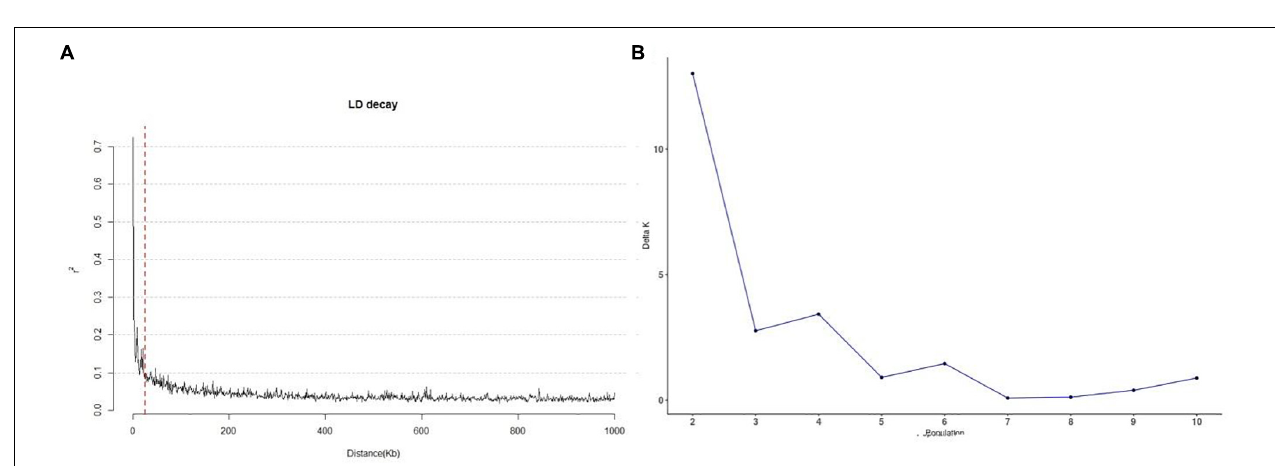
FIGURE 1 | Pearson correlation coefficients for the four yield traits evaluated in the four environments. Four environments: (A) 2015Fy, (B) 2016Tq, (C) 2016Fy, and (D) 2017Tq. Four traits: Plant height (PH), tiller number (TN), stem diameter (SD), and fresh weight per plant (FW). ** Indicates significance level at 0.01. *** Indicates significance level at 0.001.